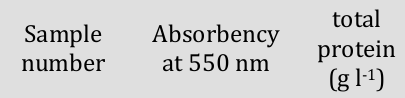
Table 4. Total proteins content in Bacillus secondary metabolites